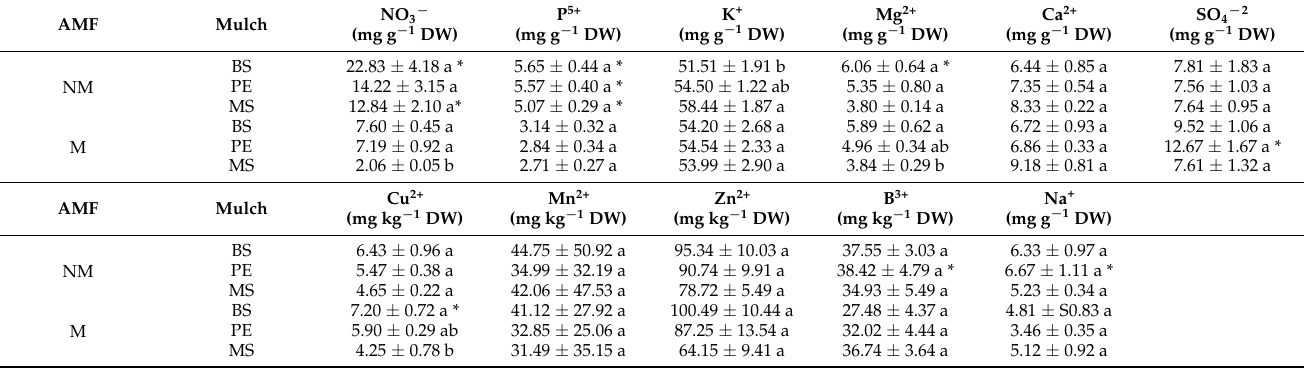
Different letters within a column show significant differences among mulching treatments while the asterisk (*) indicates significant differences due to AMF inoculation within each mulching treatment according to Tukey’s and t -tests ( p ≤ 0.05). Abbreviations used: boron (B 3+ ), calcium (Ca 2+ ), copper (Cu 2+ ), potassium (K + ), magnesium (Mg 2+ ), manganese (Mn 2+ ), nitrate (NO 3- ), sodium (Na + ), phosphorous (P 5+ ), sulphate (SO 42 − ), zinc (Zn 2+ ), bare soil (BS), polyethylene mulch (PE), and mushroom substrate-based hydromulch (MS).